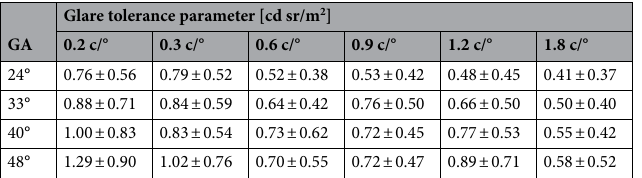
Table 2. Mean ± standard deviation in [cd sr/m 2 ] of the GT parameter for all spatial frequencies and angular sizes of the glare source.